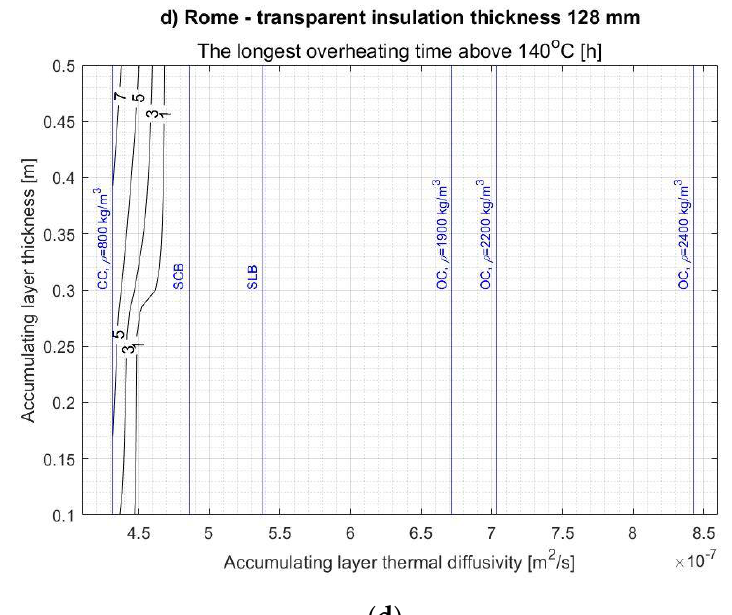
Figure A12. Contour graphs characterizing the SW basic parameters in a function of AL thermal diffusivity and thickness for the whole heating season: ( a ) the heat balance of the SW’s unit area, ( b ) the heating time, ( c ) the mean time lag of the maximum temperature on the absorber and SW’s internal surface during the day, ( d ) the longest overheating time above 140 °C in the TI. TI thickness: 128 mm. Location: Rome.